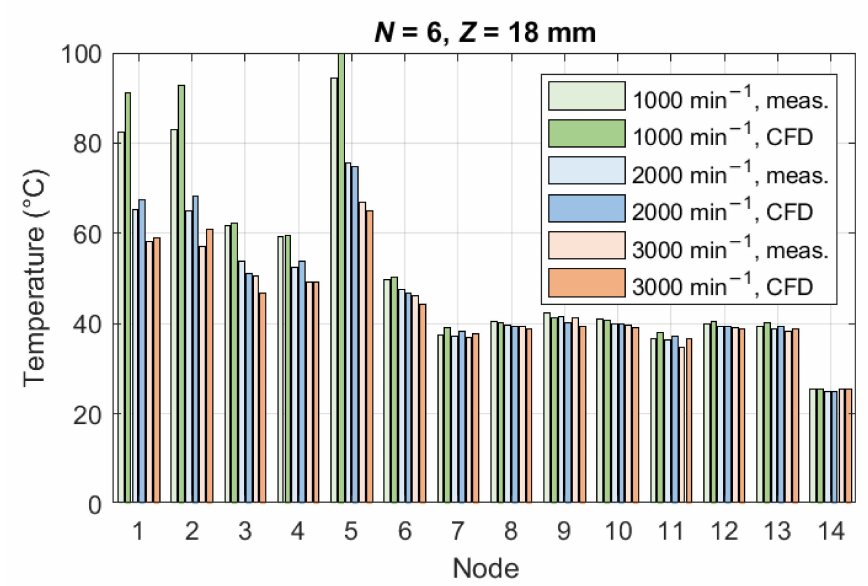
Figure 8. Temperature distribution for N = 6 and Z = 18 mm at different speeds.